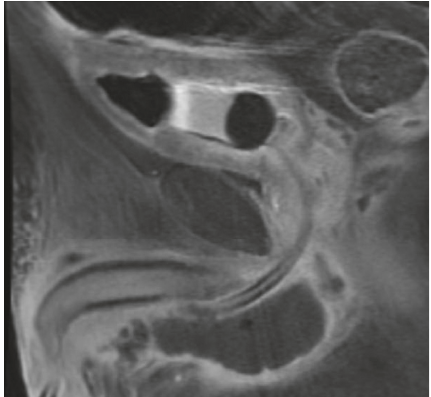
Figure 3: Sagittal view on MRI T1 image with gadolinium dem- onstrating decreased signal intensity in the corpus spongiosum compared to the corpora cavernosa consistent with reduced blood